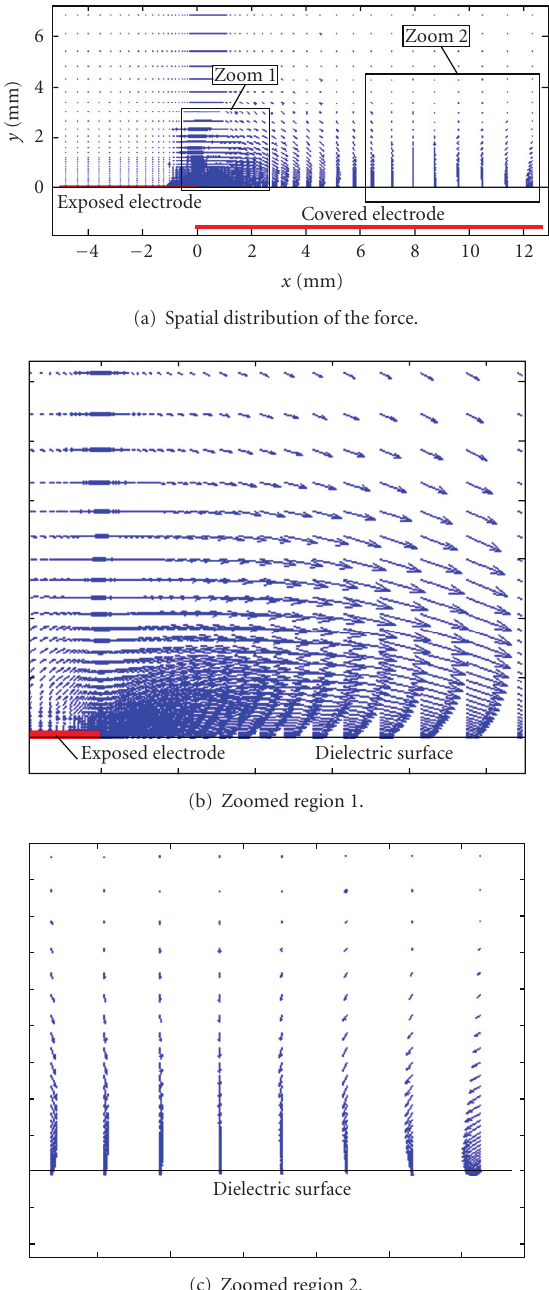
Figure 5: Time-averaged spatial force distribution generated by a plasma actuator from the “hybrid”